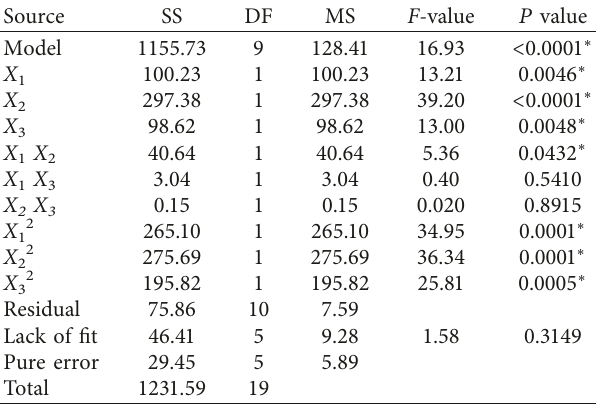
Table 7: Analysis of variance (ANOVA) for the quadratic